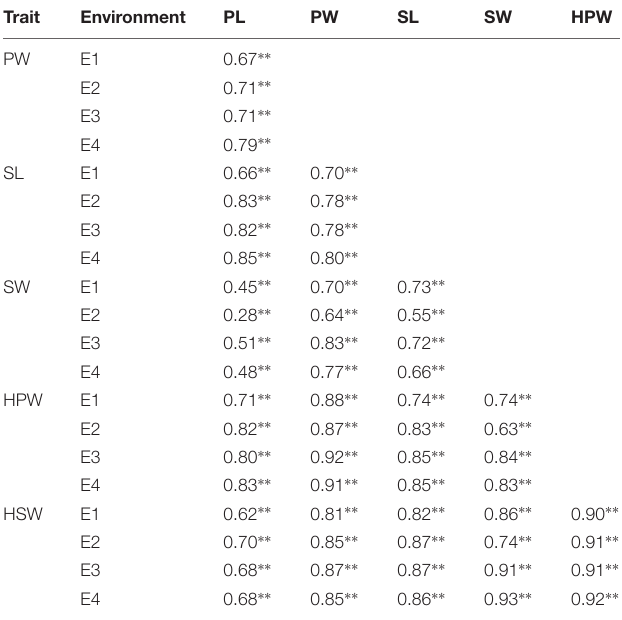
TABLE 2 | Correlation analysis for the six traits across multi-environments.